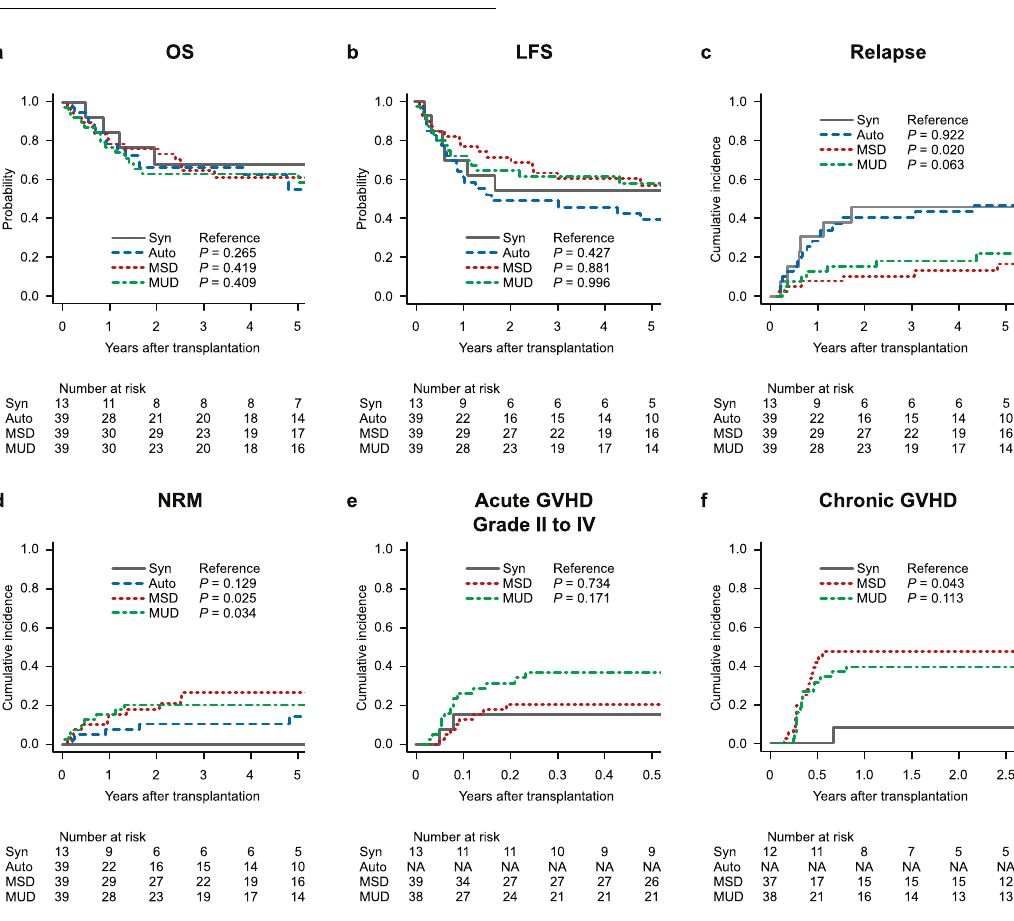
Fig. 3 Transplant outcomes according to the donor group. a Overall survival (OS) rate. b Leukemia-free survival (LFS) rate. c Cumulative incidence of relapse, d non-relapse mortality (NRM), e grade II – IV acute graft-versus-host disease (GVHD), and f chronic GVHD. Auto autologous, MSD matched sibling donor, MUD matched unrelated donor, Syn